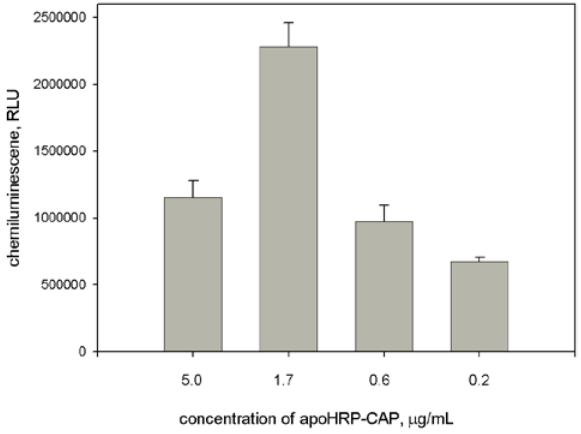
Figure 3. Dependence of light output upon concentration of apoHRP-CAP (5:1) at use of HRP-REP as a signaling conjugate. Experimental conditions: concentrations of HBV DNA and HRP-REP were 1 nM and 10 nM, respectively. Chemiluminescence was measured 8 min after the initiation of luminol oxidation. Each measurement was repeated thrice.